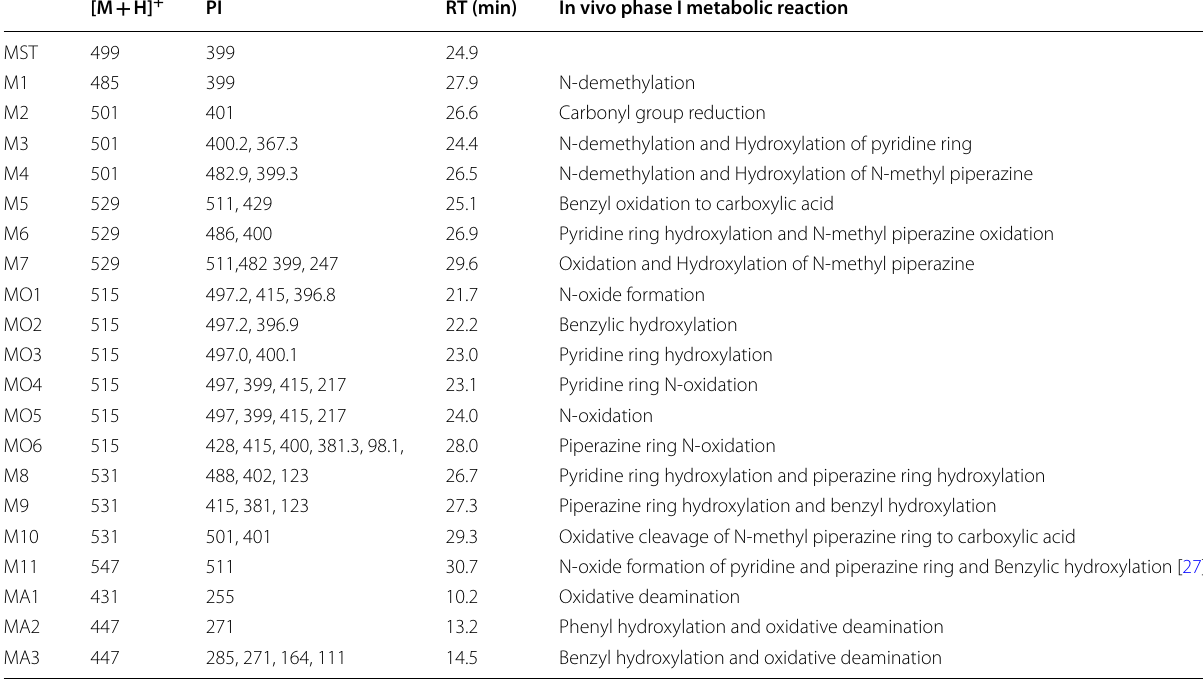
Table 3 In vivo phase I MST